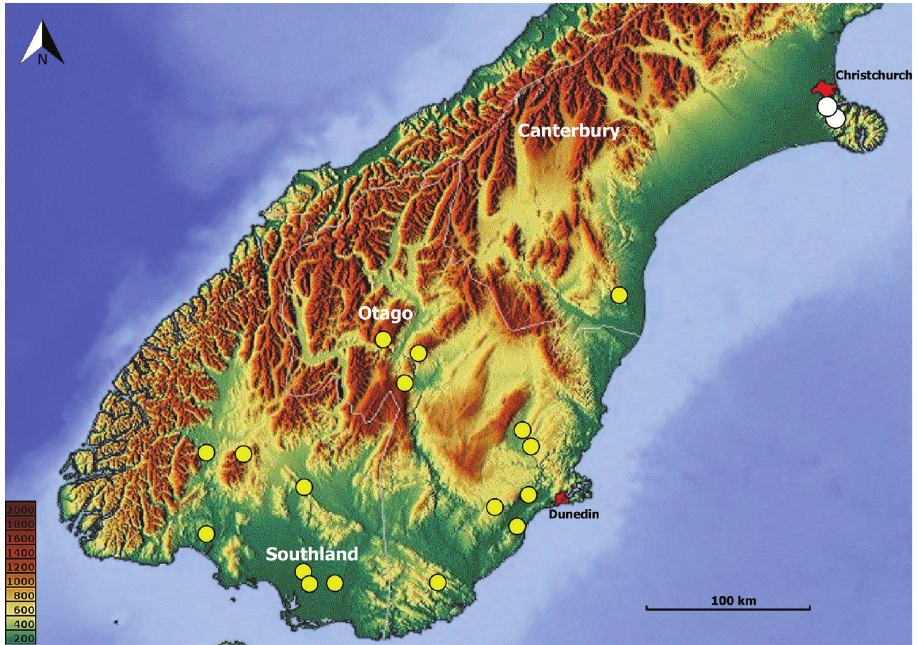
Figure 8. Map of southern half of South Island, New Zealand, showing positions of locality records for the species of Pelodiaetus : P. nunni , white circles; P. sulcatipennis , yellow circles. Elevation scale bars are given in